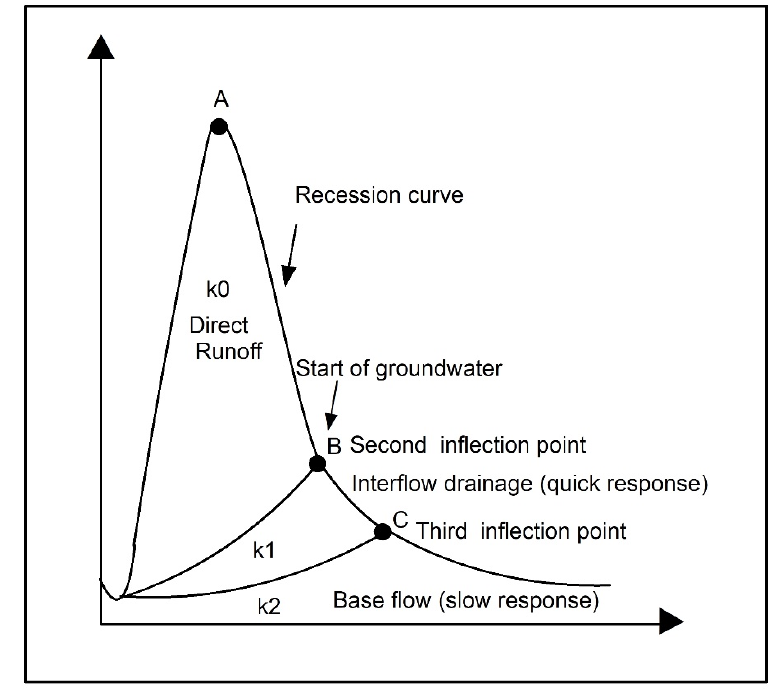
Figure 7. Conceptual diagram of the flow generation response of the M1 model.